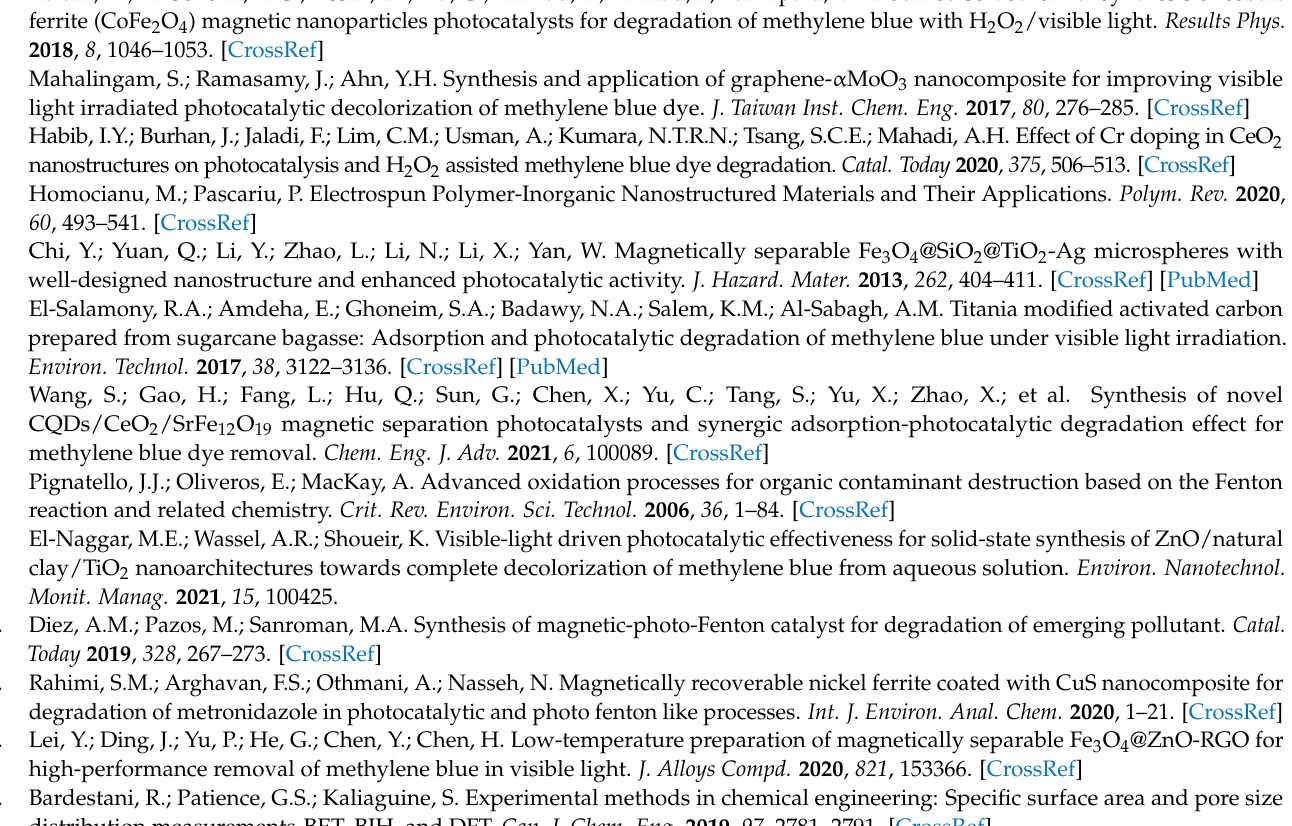
spectrophotometry, Figure S3: MB degradation at different H 2 O 2 dosages: 6g/L (circles), 3g/L (asterisk), 1.5 g/L (triangles), 0.6 g/L (crosses), 0 g/L (rhombus). The vertical grey line represents the moment of the H 2 O 2 addition, Figure S4: A: MB degradation at MB dosage of 10 ppm (white cycles), 20 ppm (triangles) and 40 ppm (black circles) with H 2 O 2 0.6 g/L and 0.8 g/L catalyst dosage B: MB degradation at same concentrations when keeping the ratio MB/H 2 O 2 and MB/catalyst dosage at 0.025 and 33.33, respectively. The vertical grey line represents the moment of the H 2 O 2 addition., Figure S5: XRD pattern of the synthesised Fe 3 O 4 -SiO 2 -TiO 2 catalyst, Figure S6: Cyclic voltammetry of TiO 2 (red), Fe 3 O 4 -SiO 2 -TiO 2 (blue) and Fe 3 O 4 (black)